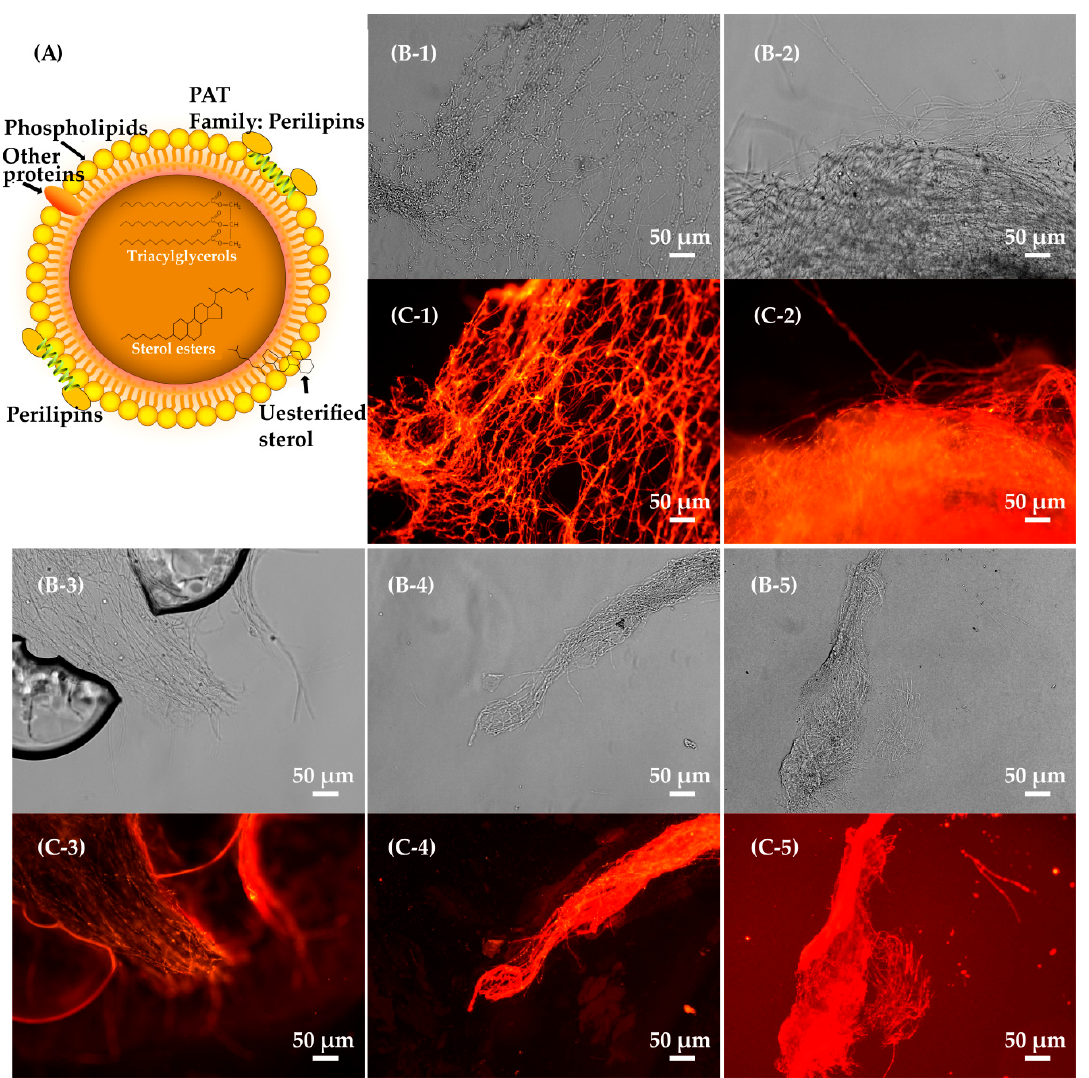
Figure 3. Image evidence of neutral lipids in lipid droplets in the mycelium of